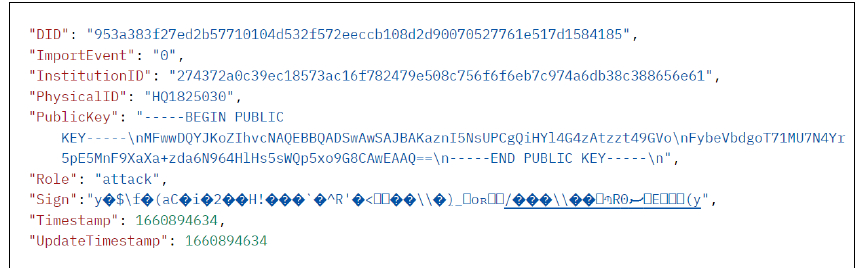
Figure 4. DID document stored on the